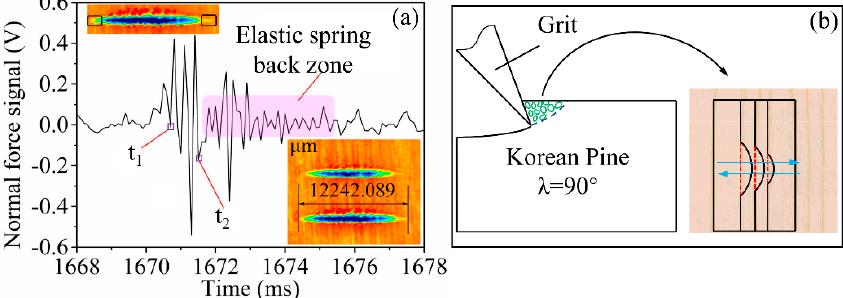
Figure 11. The analysis of elastic spring back effect when scratching Korean Pine ( λ = 90 ◦ ): ( a ) the exact match of sanding force and scratch morphology; ( b ) schematic of the elastic spring back effect when the grit was about to leave the workpiece.